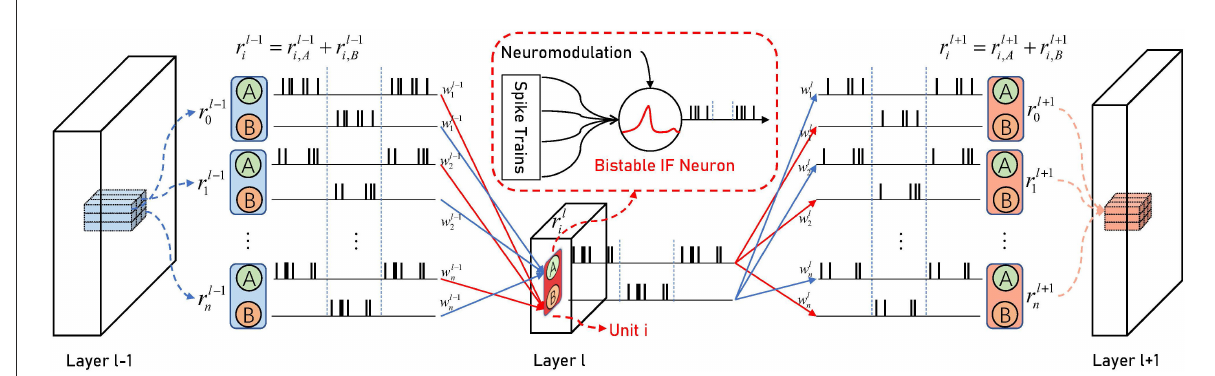
FIGURE3 The Architecture of BSNN. Neuron A in the unit, which corresponds to an ANN activation value, only has synaptic connections with neuron B in the adjacent layer and vice versa. The weights of two connections in the same unit are the same. When neuron A in the l -th layer is in the spike stage, neuron B in the ( l − 1)-th layer is in the non-spike stage. It will not cause interference to spikes of neuron A in layer l , and neuron B of the ( l + 1)-th layer can integrate the spikes until the end of the period.